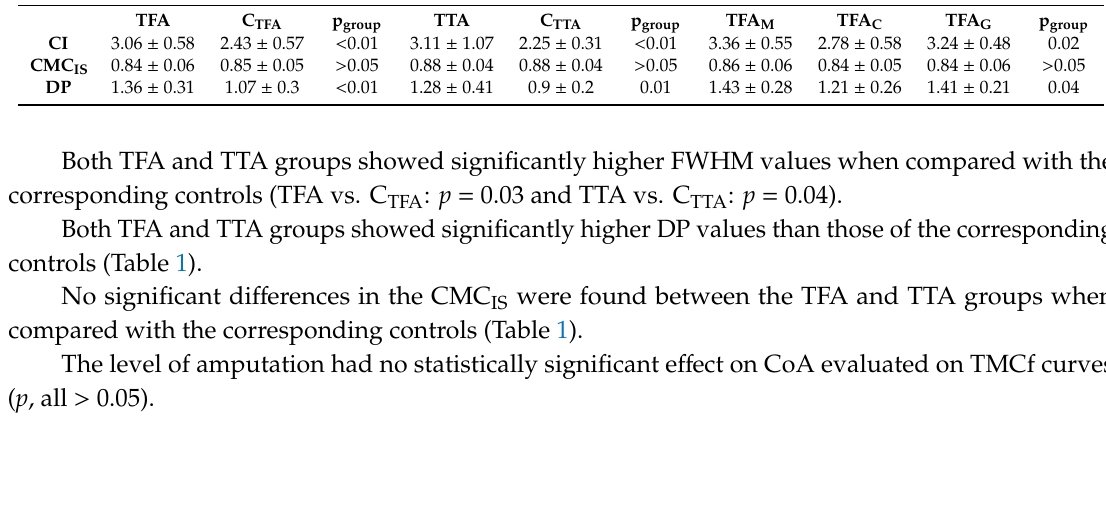
Table 1. The means, standard deviations, and statistical results ( p -values) of parameters evaluated on TMCf curves (CI: coactivation index, CMC IS : coe ffi cient of multiple correlation intra-subjects, DP: deviation phase). People with transfemoral amputation (TFA), control group matched with TFA (C TFA ), people with transtibial amputation (TTA), control group matched with TTA (C TTA ), people with transfemoral amputation with mechanical (TFA M ), CLeg (TFA C ), and Genium prostheses (TFA G ). People with Amputation versus